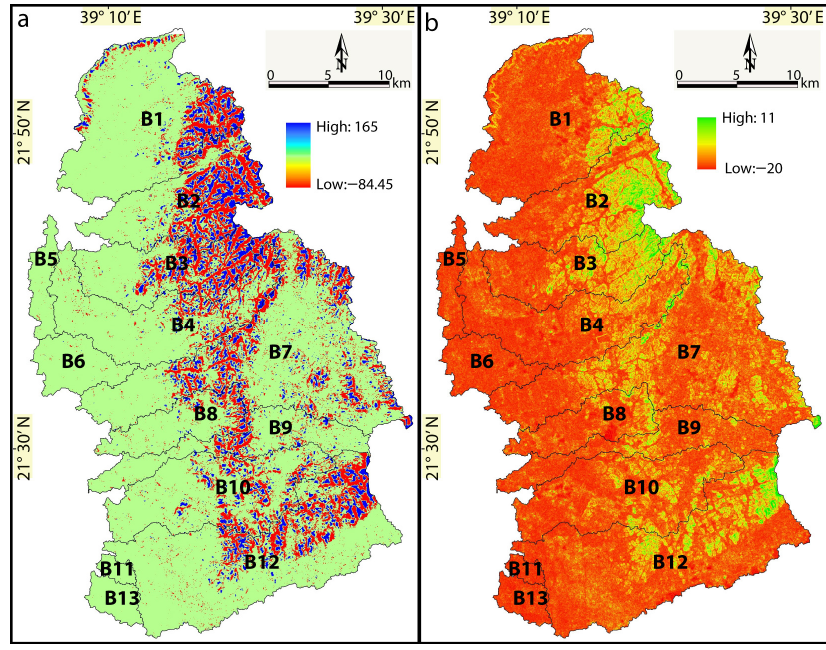
Figure 6. ( a ), Topographic position index (TPI) and ( b ), Topographic wetness index (TWI).